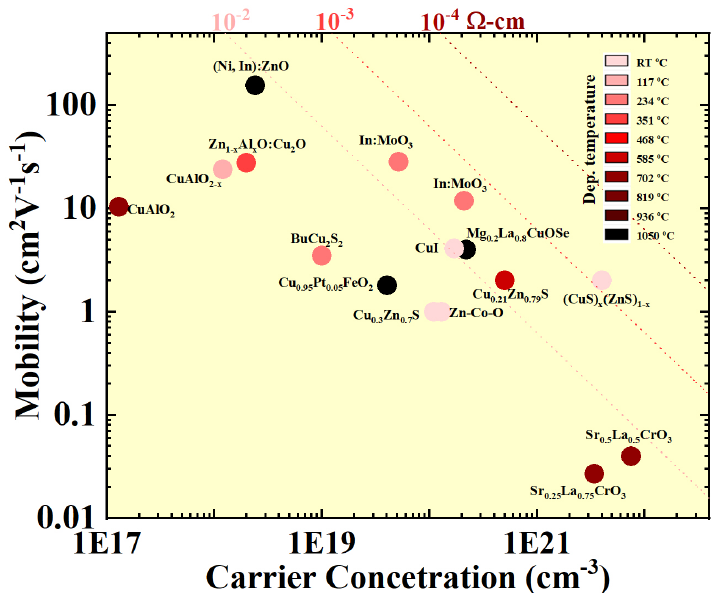
Figure 6. Mobility is plotted against carrier concentration for the highest performing p -type TCMs. Datapoints present the obtained mobility for the corresponding carrier concentration. The colour of the circles signifies the deposition temperature of the film. Dotted lines represent the line of equal